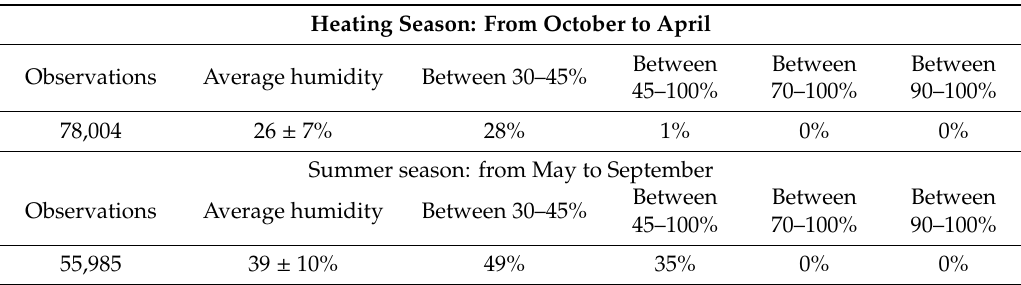
Table 7. Average RH observations and the observations within the boundaries.